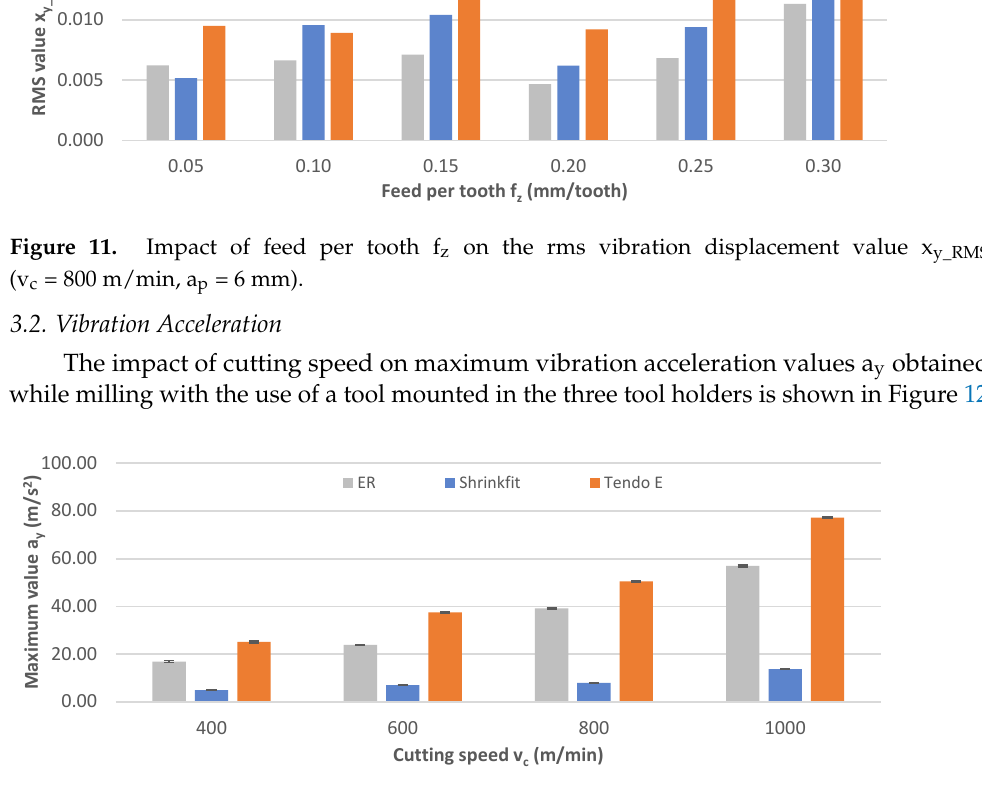
Figure 10. Impact of feed per tooth f z on the vibration displacement amplitude Ax y (v c = 800 m/min, a p = 6 mm). The rms vibration displacement values x y_RMS obtained at a variable feed per tooth are shown in Figure 11. During the machining process, the recorded values were 0.012 – 0.023 mm, with the lowest feed per tooth of f z = 0.05 – 0.15 mm/tooth for the heat shrink chuck, f z = 0.20 mm/tooth for the hydraulic chuck, and f z = 0.25 – 0.30 mm/tooth for the ER values, with the exception of f z = 0.20 mm/tooth, which demonstrated a decrease.